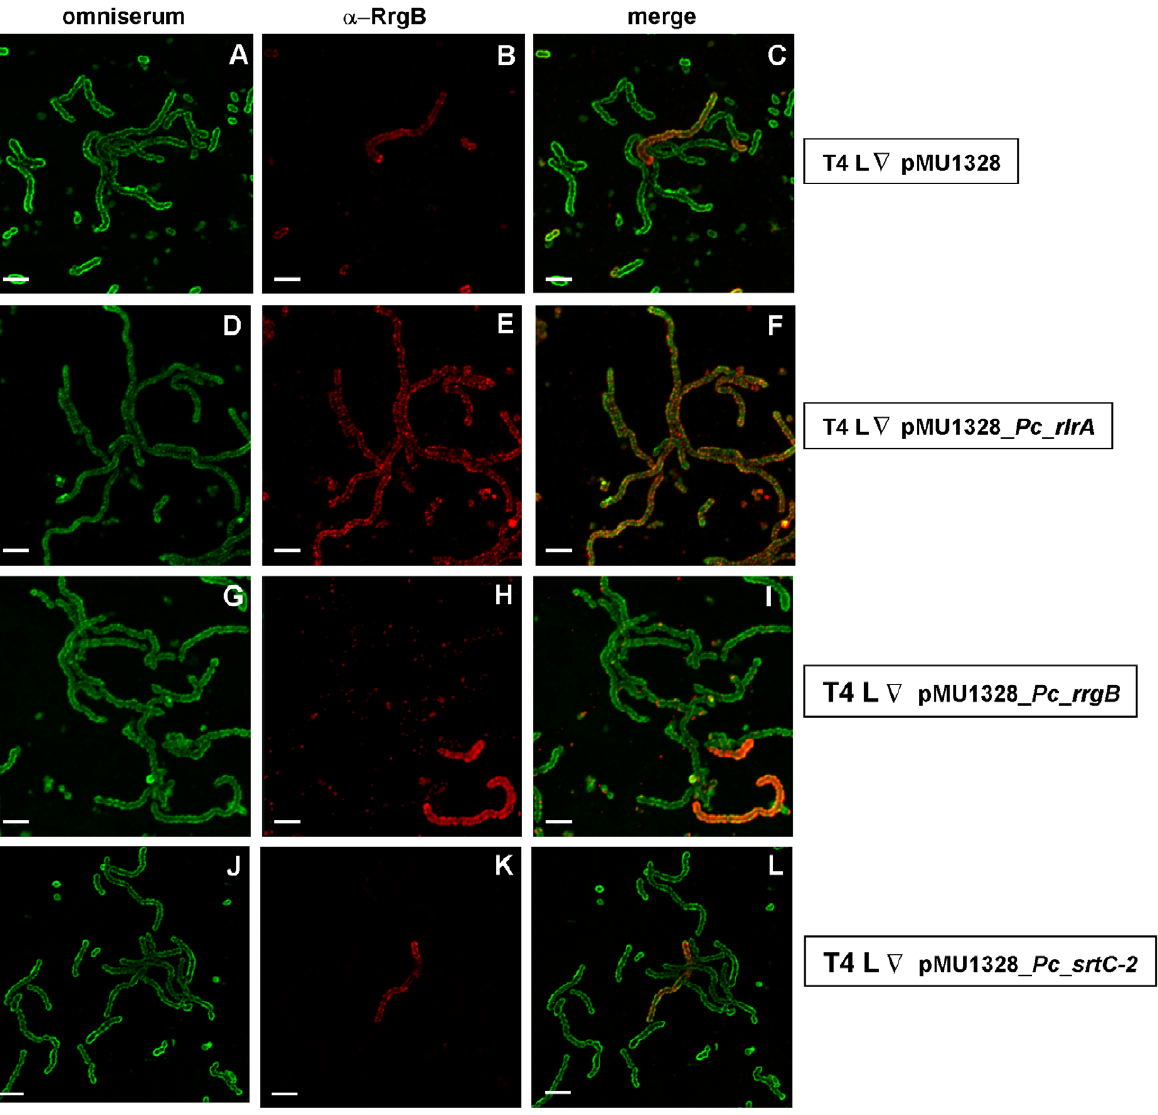
Figure 6. RlrA expression in pilus negative (Pil-) bacteria induces pilus polymerization. TIGR4 low pilus expressing bacteria transformed with pMU1328 (panels A-C), pMU1328-Pc-rlrA (panels D-F), with pMU1328-Pc-rrgB (panels G-I) or with pMU1328-Pc-srtC-2 (panels J-L) were processed for confocal microscopy immuno-fluorescence analysis by incubating S. pneumoniae with anti-capsular antibodies (Omniserum 1:2000 dilution) (green, left panels) and mouse anti-RrgB antibodies (1:2000 dilution) (red, central panels). Right panels represent the merged signal of the left and central panels. Scale bar is 4 m m.